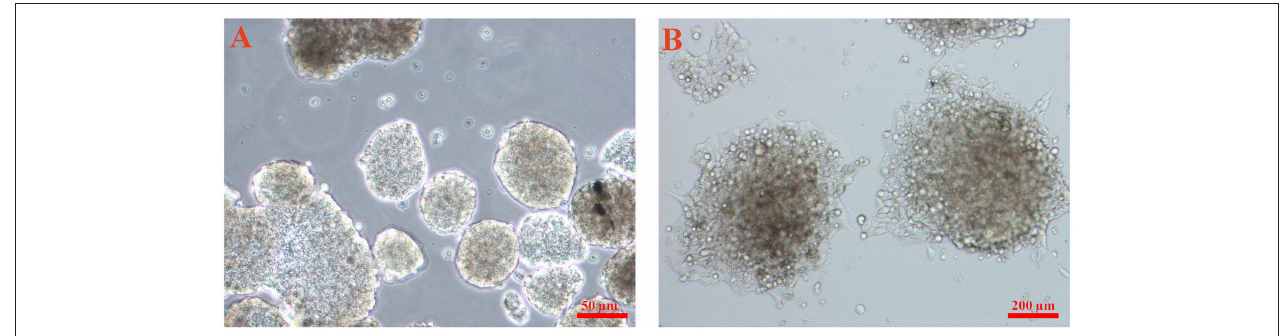
FIGURE 1 | The inverted microscopy image of the iPSCs used for the experiments. (A) The cells cultured in tissue culture plates (TCPs) and (B) cultured on the feeder layer.